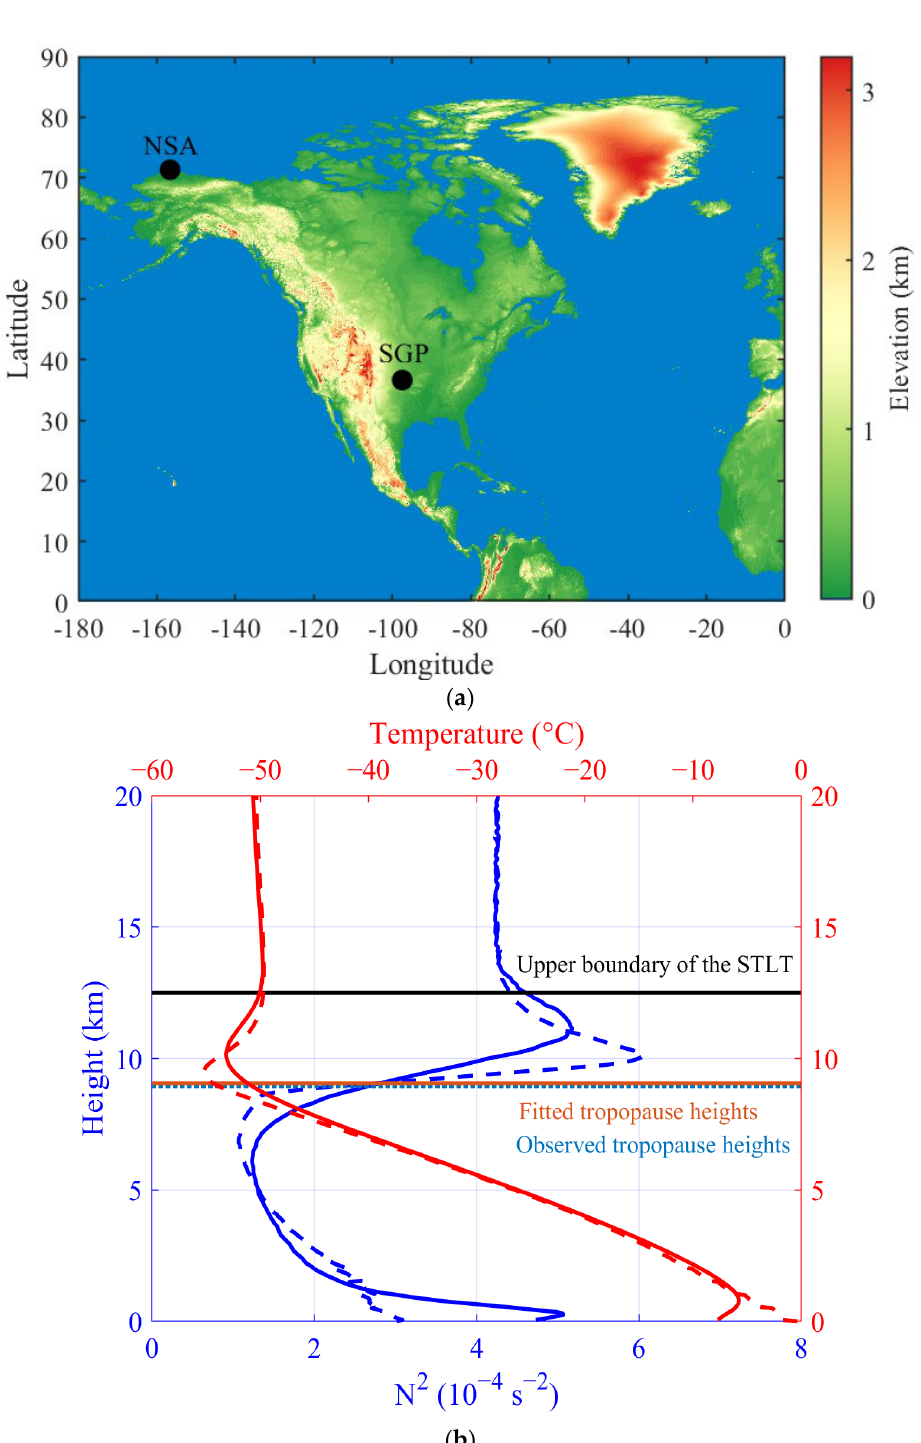
Figure 1. ( a ) Locations of the radiosonde sites at the ARM SGP Central Facility (36.6° N, 97.5° W, 315 m ASL) and NSA Barrow (71.3° N, 156.6° W, 8 m ASL) that were used in this study. ( b ) A schematic of the tropopause profiles marking the relevant heights and systems that were used in the study. The red and blue lines denote the temperature and stability in the GB-system (solid) and TB-system (dashed). The horizontal dashed green line denotes the observed tropopause height, which is recognized as the bottom boundary of the stability transition layer around the tropopause (abbreviated as STLT in the figure) in this study, and the horizontal solid black line represents the upper boundary of the STLT. The horizontal dashed brown line represents the fitted tropopause height, which is quite close to the observed tropopause height.